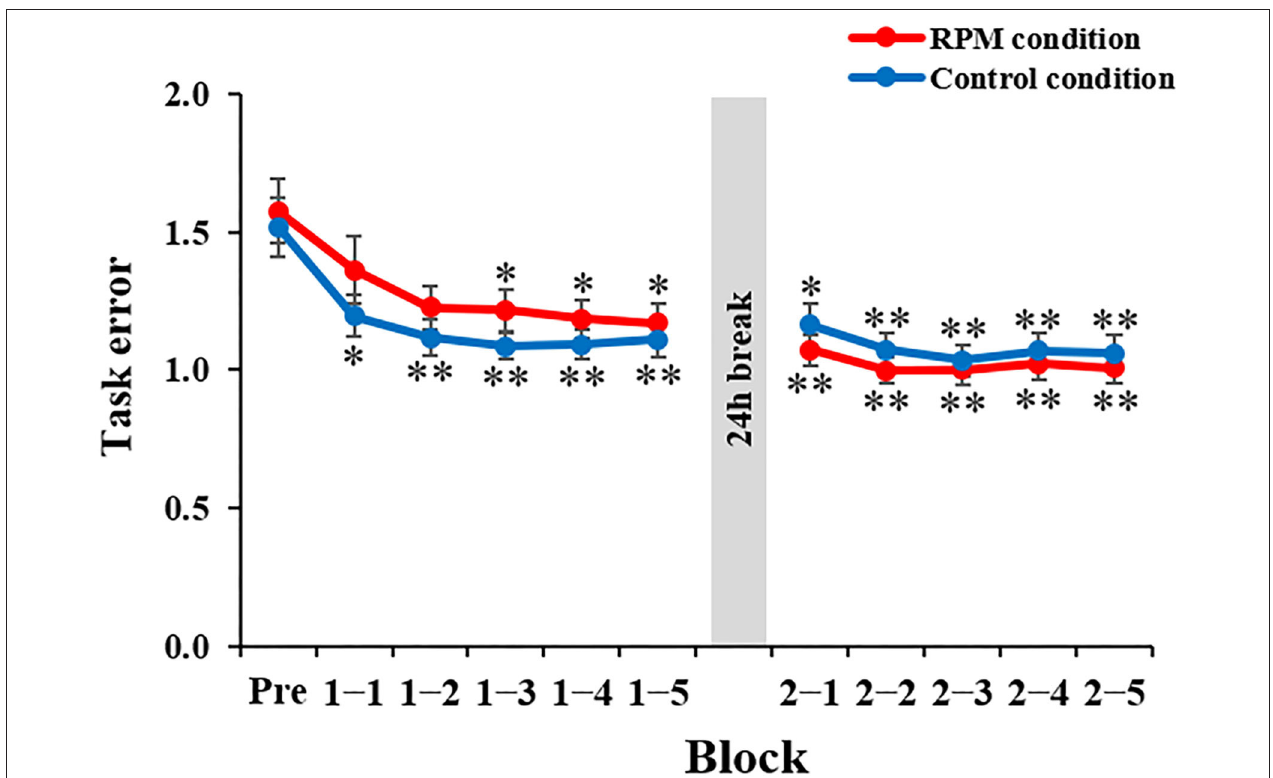
FIGURE 5 | Change in the task error in each condition. The red line shows the average task error under RPM conditions. The blue line indicates the average task error of the control condition. The error bars indicate the standard error (SE). * P < 0.05 (vs. Pre); ** P < 0.01 (vs.